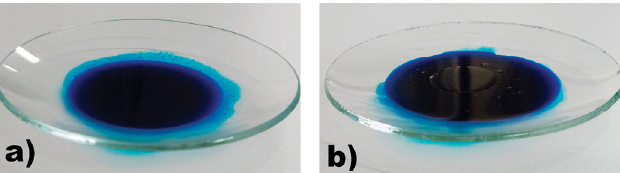
FIGURE 2 - Dye Method results; (a) dilution of samples A; (b) Example of the mixture of vaseline in the coloring solution for sample